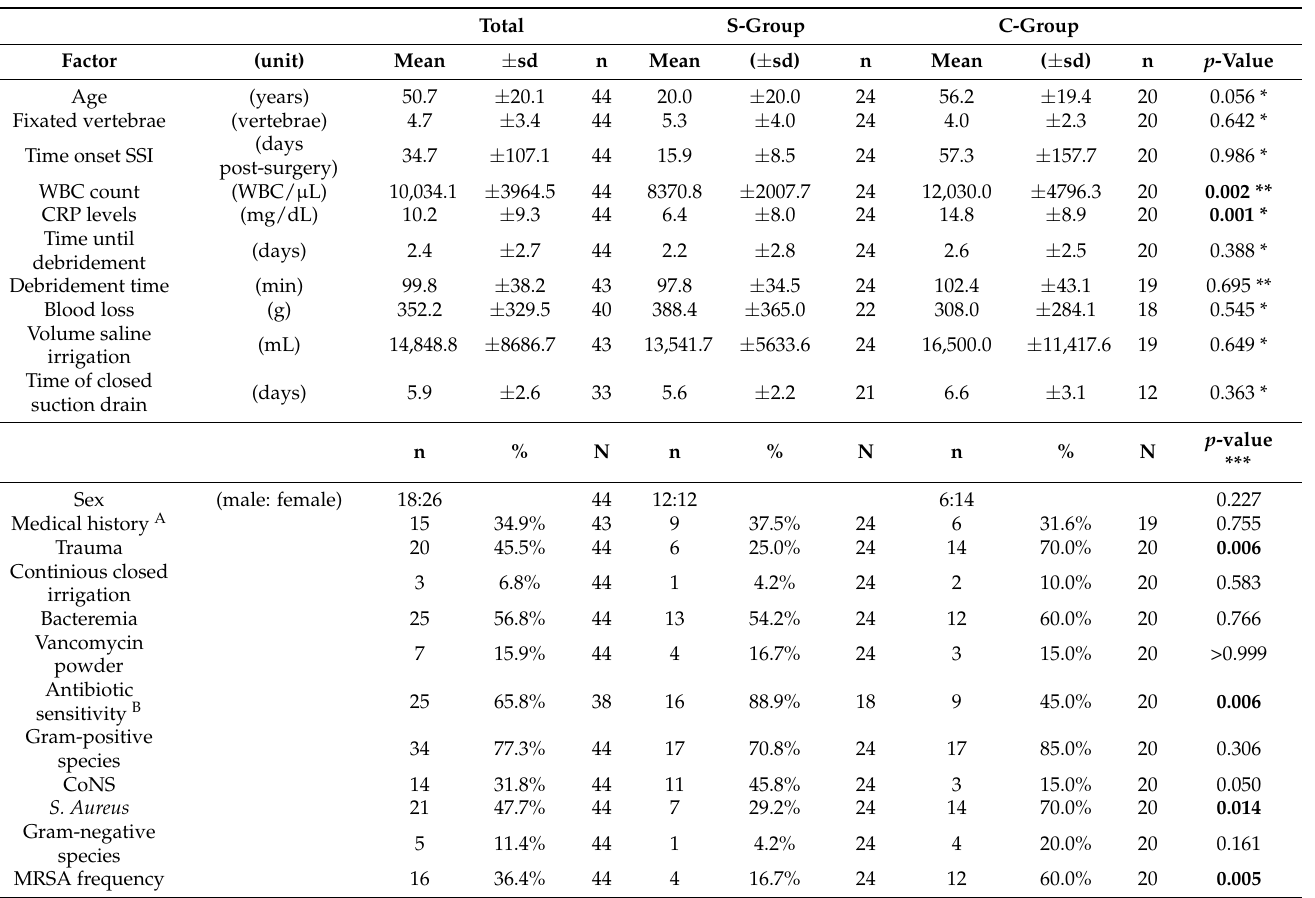
Table 2. Demographic and treatment characteristics for successful, instrumented, deep surgical site infection treatment by single debridement (S-group) compared to unsuccessful treatment, thus requir- ing multiple debridement interventions and/or removal of the implanted instruments or resulted in death (C-Group). A; selection of sensitive antibiotic treatment prior to microbe examination. Assessed through * Mann–Whitney U test, ** Unpaired t -test, or *** Fisher’s exact test. A: presence of diabetes, rheumatoid arthritis, or hemodialysis as risk factors for SSI; B: selection of effective antibiotic regimen against SSI causative bacteria at initial week of onset. Abbreviations: CoNS, coagulase-negative staphylococcus; CRP, C-reactive protein; MRSA, Methicillin–resistant Staphylococcus aureus ; SSI, surgi- cal site infection; sd, standard deviation; and WBC, white blood cells. Statistical significant p -values are marked in